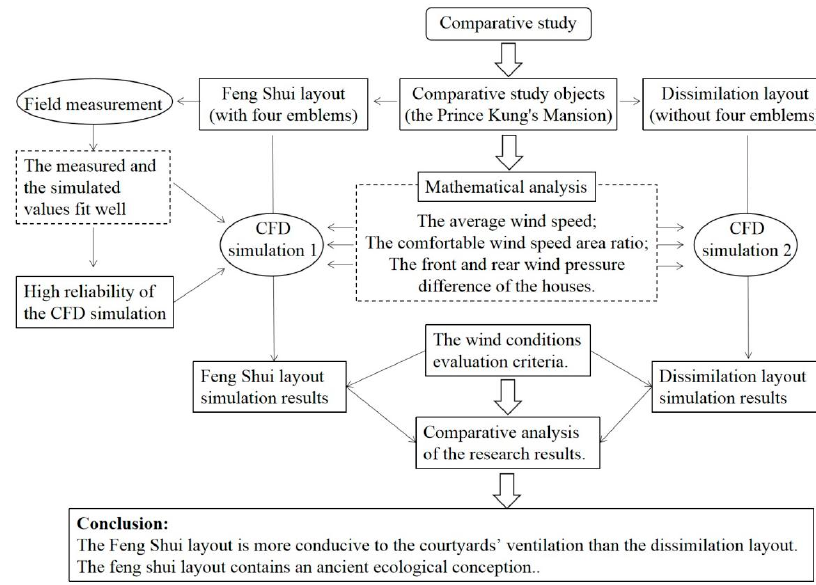
Figure 2. Research